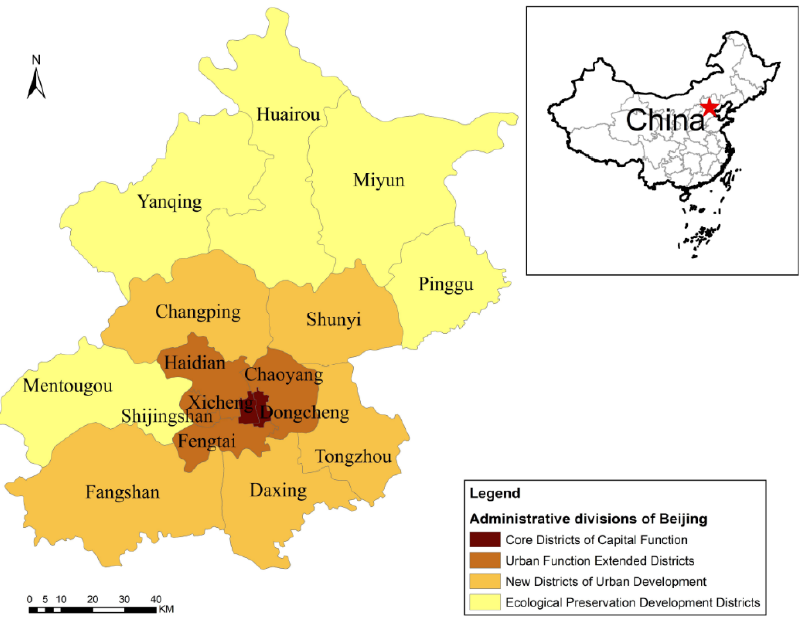
Figure 1. Map of the administrative districts of Beijing according to their different urban functions and their locations in China.